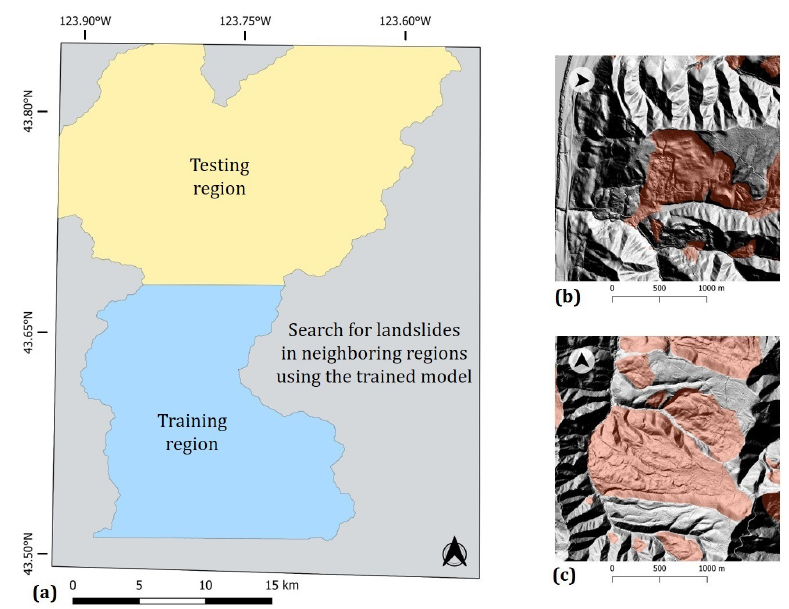
Figure 4. ( a ) Partition of the landslide inventory into training and testing region ( b , c ) Example of landslide from SLIDO database shown in red overlay on top of Lidar DEM derived hillshade. The maps are in UTM Zone 10N with WGS 84 datum